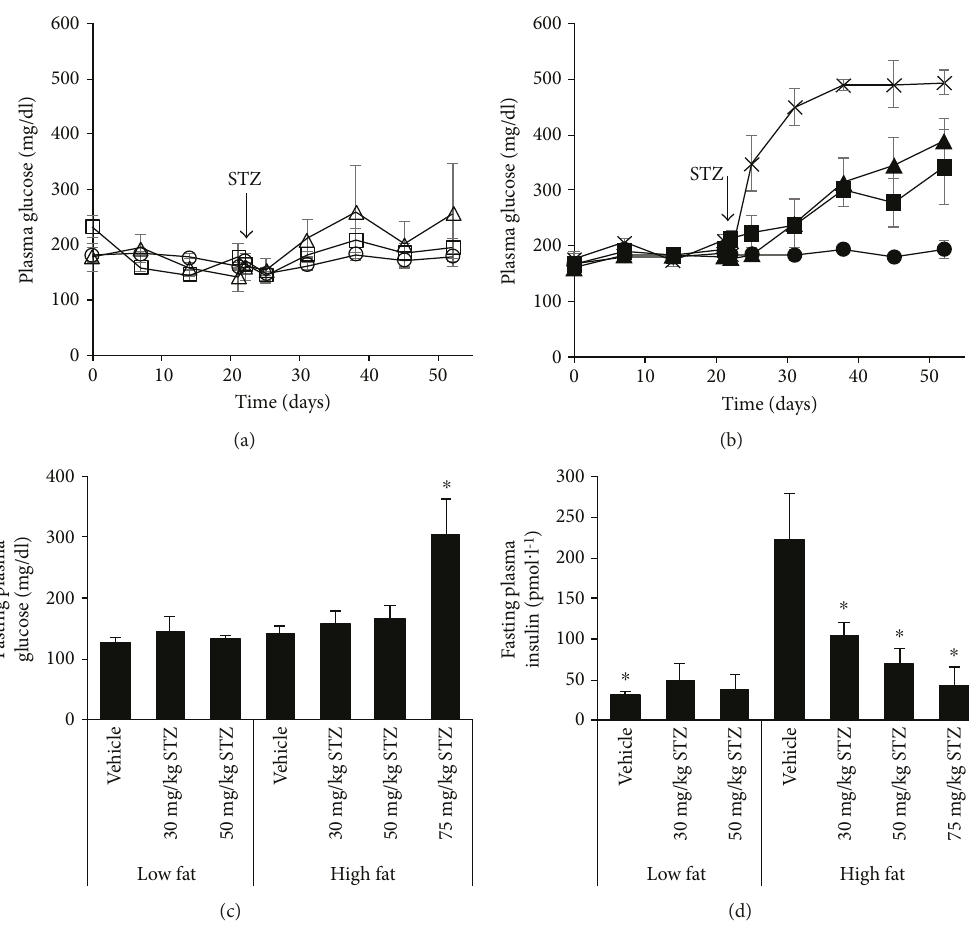
Figure 2: Fed plasma glucose over time in low (a) and high (b) fat-fed mice treated with three consecutive once-daily doses of vehicle or 30, 50, or 75 mg/kg STZ. 16-hour fasted plasma glucose (c) and insulin (d) levels four weeks after vehicle or STZ treatments. Treatment groups are denoted as follows: low fat — vehicle, open circles ( n = 4 ); low fat — 30mg/kg STZ, open squares ( n = 4 ); low fat — 50 mg/kg STZ, open triangles ( n = 4 ); high fat — vehicle, closed circles ( n = 4 ); high fat — 30 mg/kg STZ, closed squares ( n = 3 ); high fat — 50 mg/kg STZ, closed triangles ( n = 6 ); and high fat — 75 mg/kg STZ, × ( n = 3 ). Data are means ± SEM . ∗ p < 0 05 versus high fat —